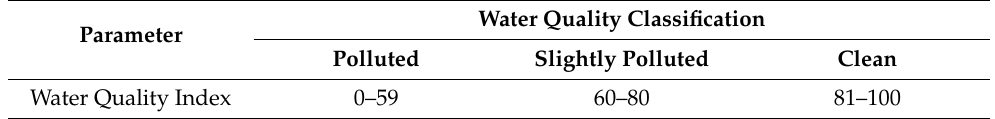
Table 2. Water Quality